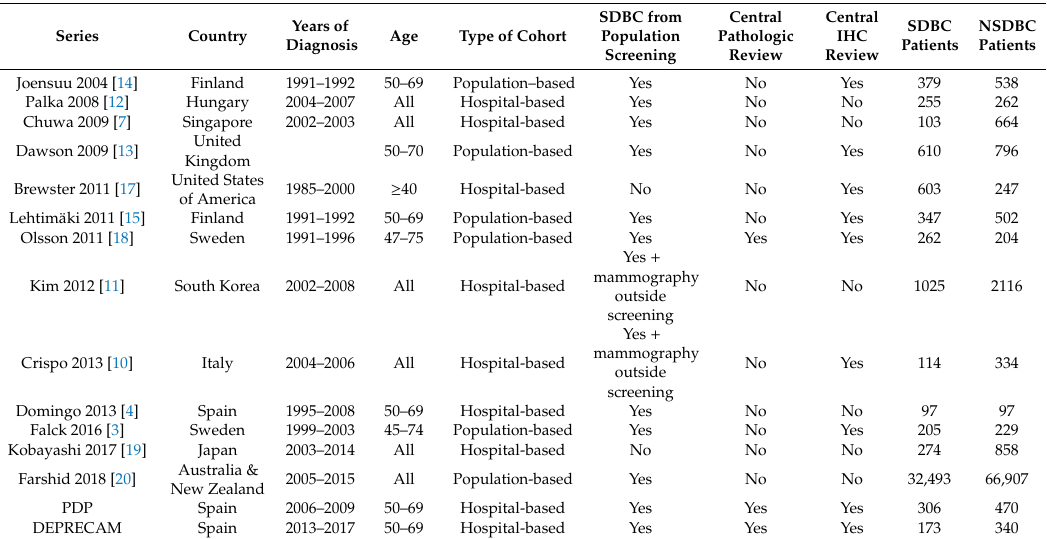
Table 7. Features of the series.